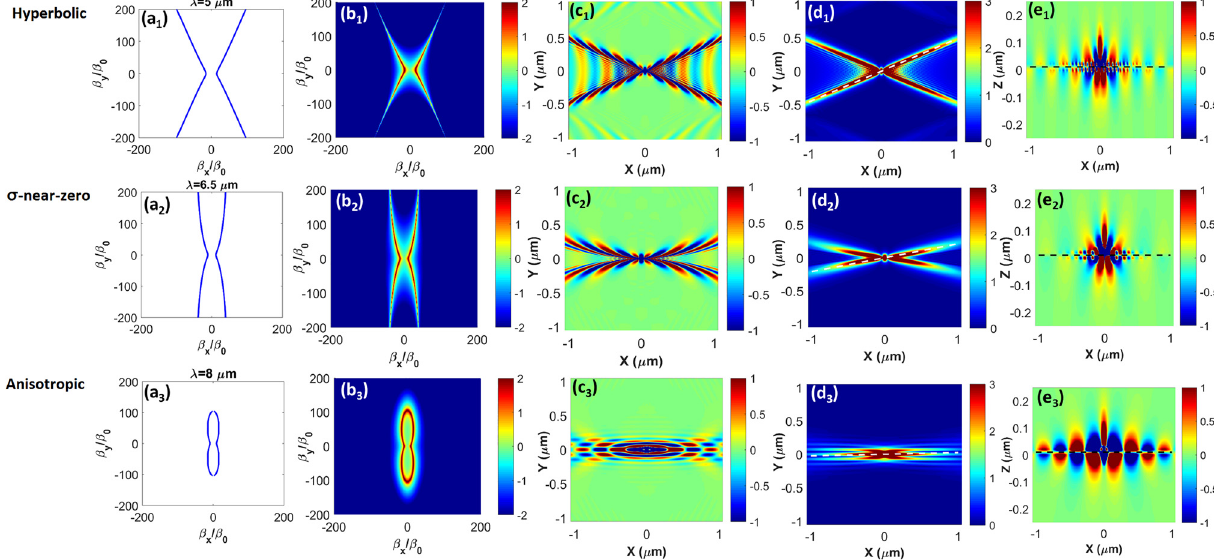
Figure2: (a i )EFCs,(b i )transmissioncoef fi cients,and[(c i ) – (e i )]densityplotsofelectric fi eldsassociatedwithSPPssupportedbyasuspended A2DM sheet [Figure 1(a)] with n (cid:1) 10 14 cm − 2 ; (c i ) and (d i ) are the top-view spatial distributions of Re( E z ) and | E z | , respectively, and (e i ) are the side-view of the fi eld. The panels denoted by subscripts 1, 2, and 3 correspond to λ (cid:1) 5 μ m, 6 . 5 μ m and 8 μ m, respectively; dashed horizontal line shows the location of the A2DM